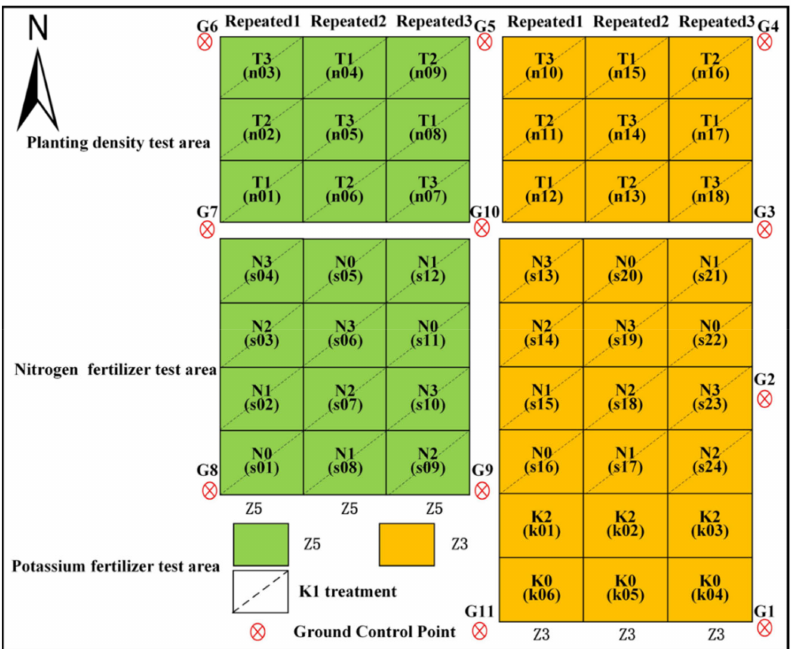
Figure 2. Experimental